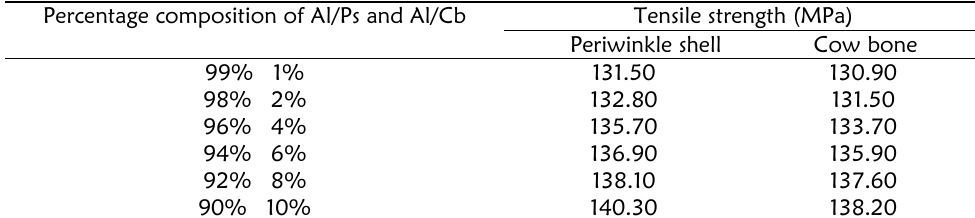
Table 5: Tensile strength of Al-wt % Ps and Cb knee brace produced Percentage composition of Al/Ps and Al/Cb